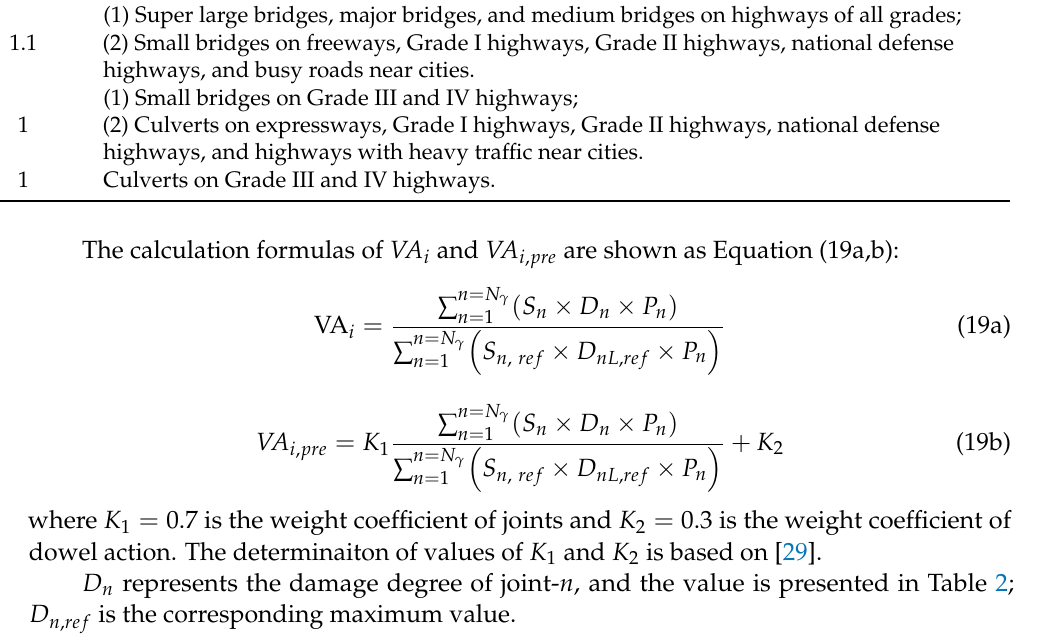
Table 2. D n values representing the damage degree of joint- n